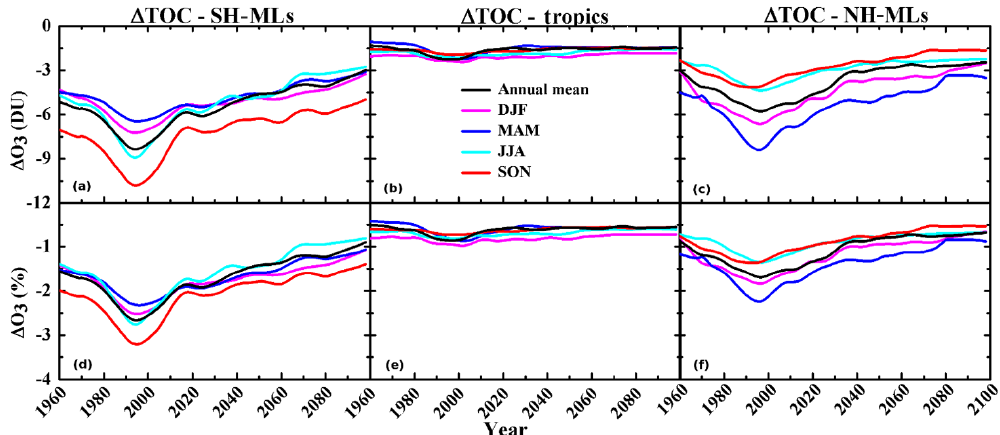
Figure 4. Temporal evolution of total ozone column difference ( (cid:49) TOC) between the experiments. Panels (a–c) show the annual and seasonal mean absolute (cid:49) TOC (DU) at SH-MLs, in the tropics, and at NH-MLs, respectively, while panels (d–f) show the corresponding relative (cid:49) TOC